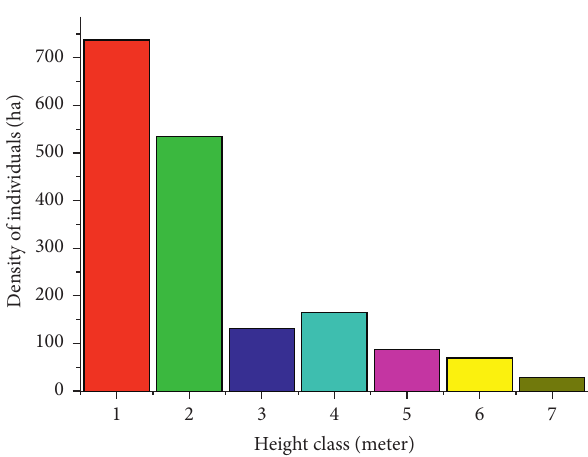
Figure 6: Density of individual woody plants in different height distributions of the forest. Height class 1 ranges from 2.1 to 6m; 2